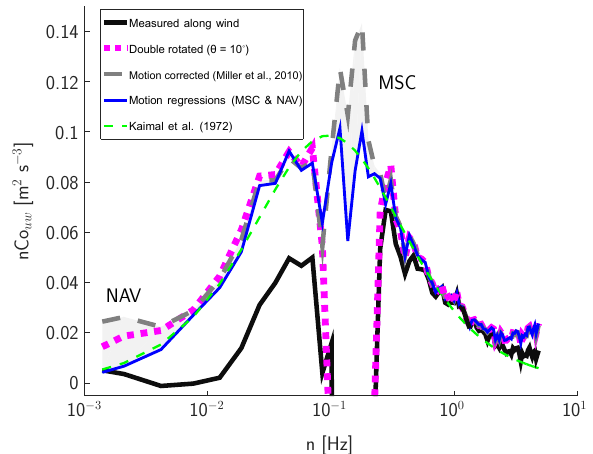
Figure 1. Average along-wind momentum-flux cospectra (220min period, relative wind direction α = 15 . 5 ◦ , u ∗ = 0 . 62ms − 2 ). Shown are spectra for different tilt-motion corrections: (i) the measured wind speed corrected only for instantaneous platform orientation and wind direction ( u me ) (black line); (ii) corrected for the verti- cal tilt of the streamline ( θ = 10 ◦ ) (dashed magenta line); (iii) the tilt-motion-corrected wind speed (Landwehr et al., 2015) (dashed grey line); (iv) additional application of the motion-scale correc- tion (MSC), which was adapted from Prytherch et al. (2015) and regression with speed and heading (NAV) (thin blue line); (v) also shown is the semi-empirical shape of the cospectrum (Kaimal et al., 1972) (green dashed line). The shaded area marks the part of the momentum-flux signal that was removed by the MSC and NAV re- gressions. In this case, the reductions were 5 and 3% of the u ∗ estimate,